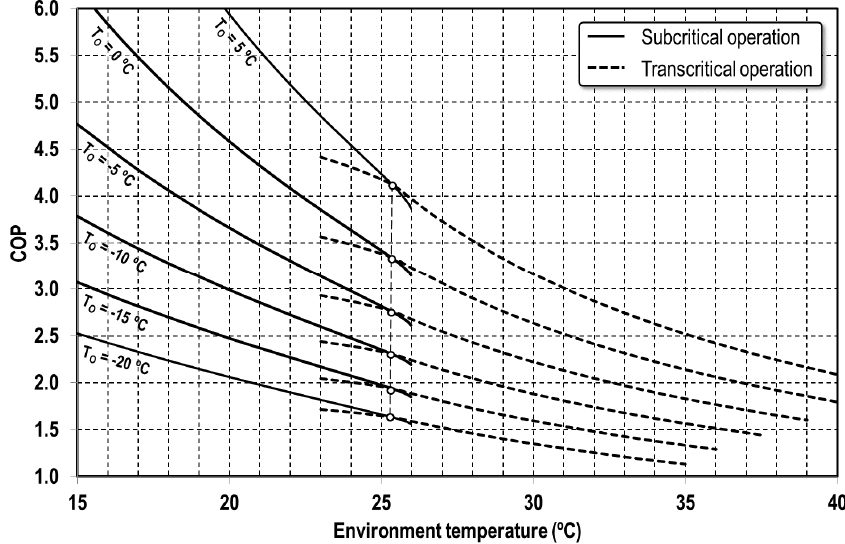
Figure 5. COP dependence on the subcooling degree of MS cycle. (T o = 0 °C).